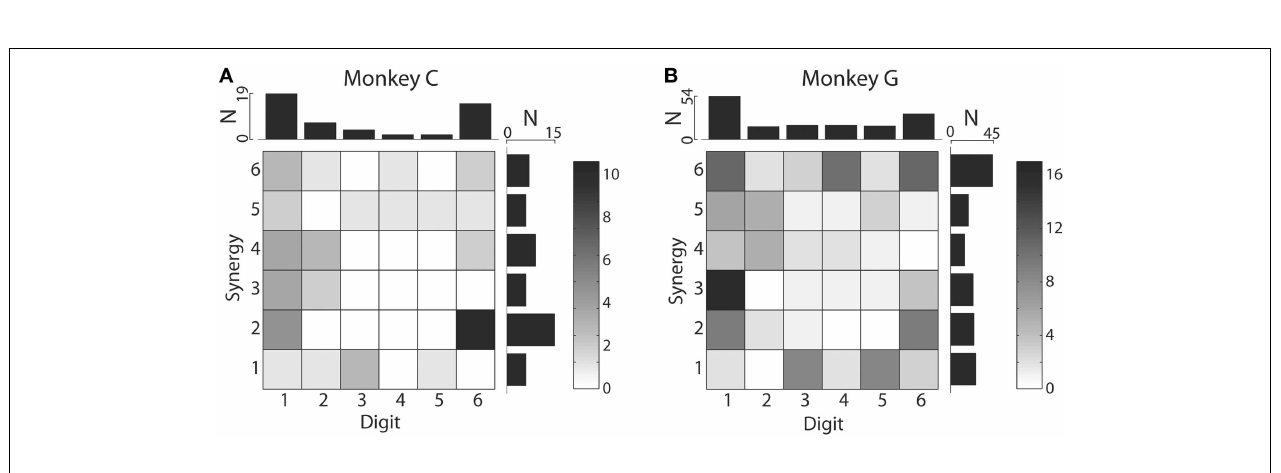
marginal histograms above shown that in both monkeys, the largest number of M1 neurons were best correlated with the thumb and then with the wrist, whereas the synergy with which the largest number of M1 neurons were best correlated differed between monkeys: S2 for monkey C, S6 for monkey